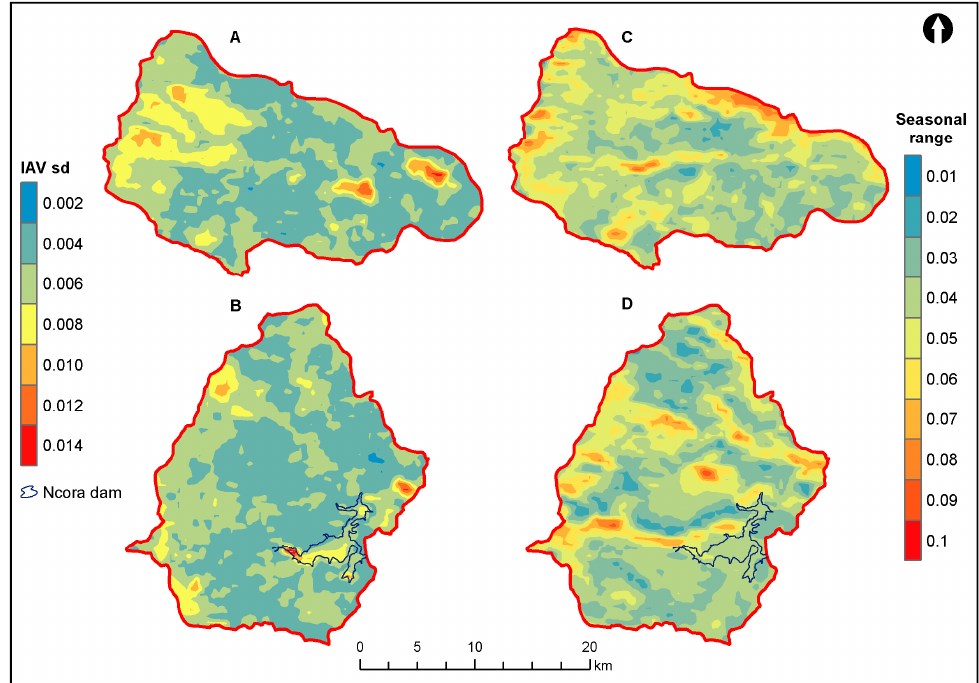
Figure 9. Inter-annual variability (IAV) standard deviation (sd) (A-T35B, B-S50E) and seasonal range (C-T35B, D-S50E) measured on all pixels from the 8-day MODIS product. Over the study period of 15 years, albedo in S50E fluctuated annually with a mean of 0.0041, very similar to the mean of 0.0045 in T35B. However, the IAV for the two catchments were found to be significantly different (p < 0.001; Wilcoxon rank sum test). The highest frequency of pixels varied with standard deviations (sd) between 0.003 and 0.005. Similarly, the mean seasonal cycle in the two catchments—based on 8-day MODIS albedo values—are significantly different (p < 0.001; Mann- Whitney U test for non-parametric data). The albedo can vary between 0.01 and 0.08. Distinct spatial patterns are noted in the maps in Figure 9. 3.4 Modelling ET and NPP In Table 6, the area percentage for modelled persistent land cover classes in 2030 are compared with the size of these land cover classes in 2014. Table 6 also includes the net change, as well as the mean trend calculated from MODIS. Based on the mean MODIS PSA change and relationships with NPP and ET, three scenarios for future NEE and water use were calculated: (1) lower mean albedo indicating proliferation of woody vegetation; (2) mean albedo, the status quo persists; and (3) higher mean albedo, with conversion to agriculture and urban intensification dominating future transitions. Table 6. Modelled net ecosystem carbon exchange (NEE) and water use for persistent land cover classes in S50E (bold) and T35B (italics). Land cover class UG (grassland)